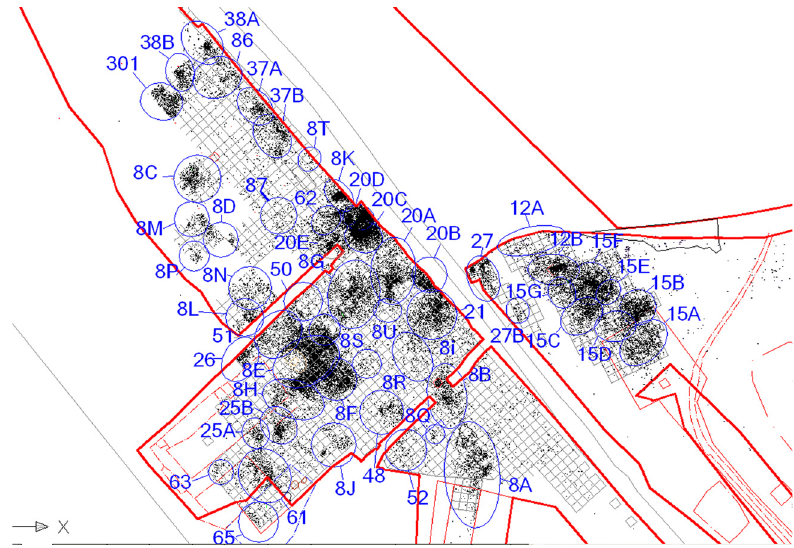
Figure 3: Area 15 and its fl int scatters.